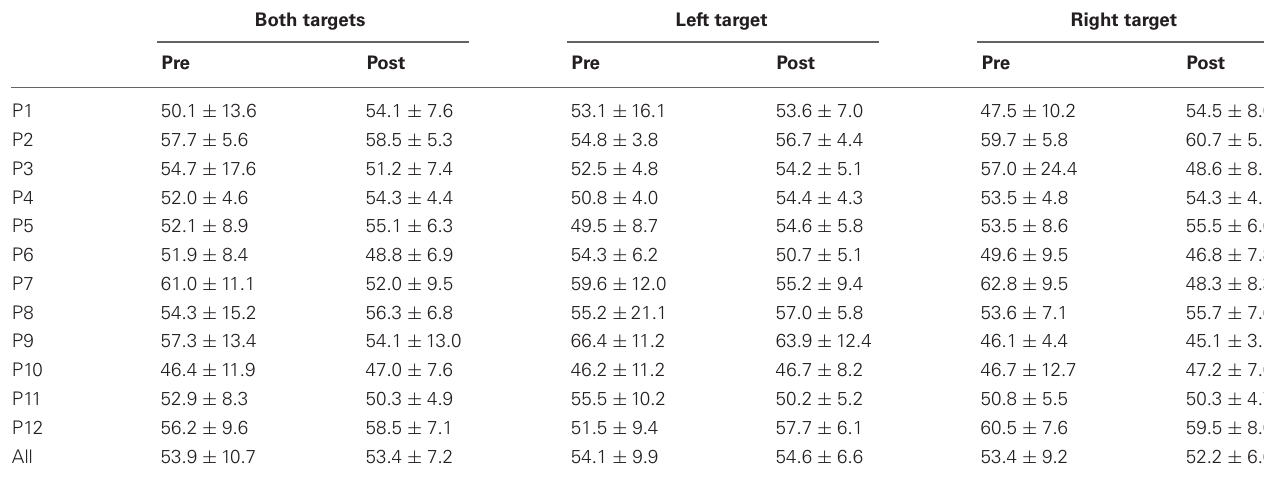
Table 2 | Mean ± Standard deviation of duration in milliseconds for both, left, and right targets in the two periods, for every participant and the group of participants